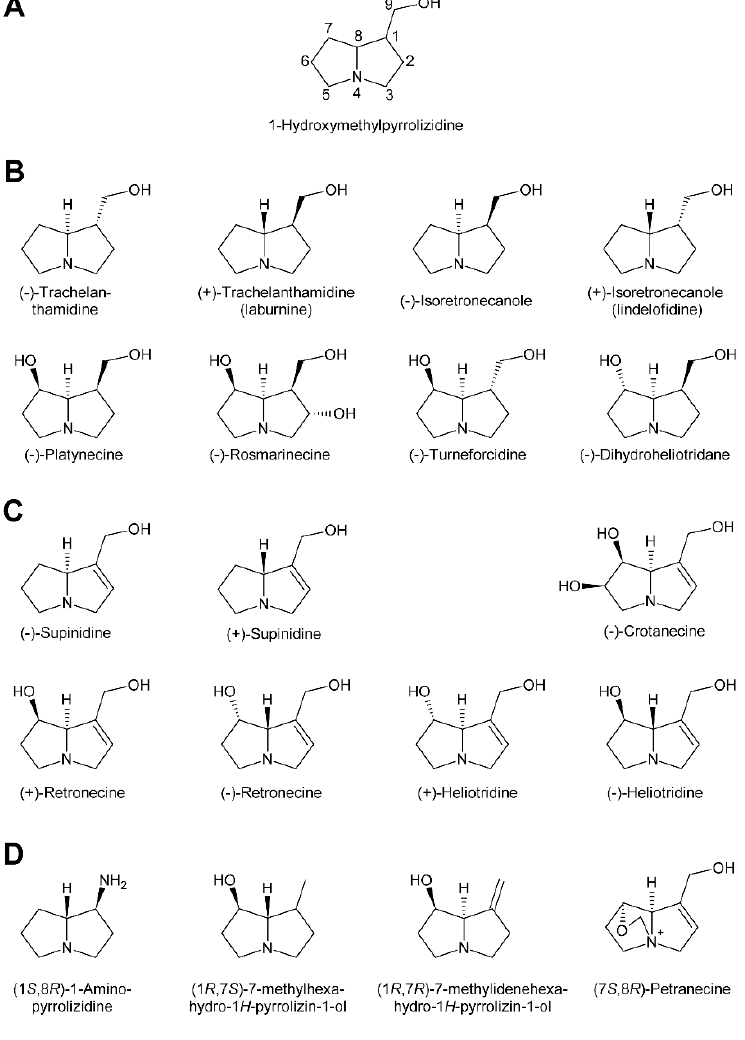
Figure 2. Structures of necine bases. ( A ) Basic structures and numbering of atoms in necine bases. ( B ) Saturated necine bases. ( C ) 1,2-Desaturated necine bases. ( D ) Unusual necine bases.